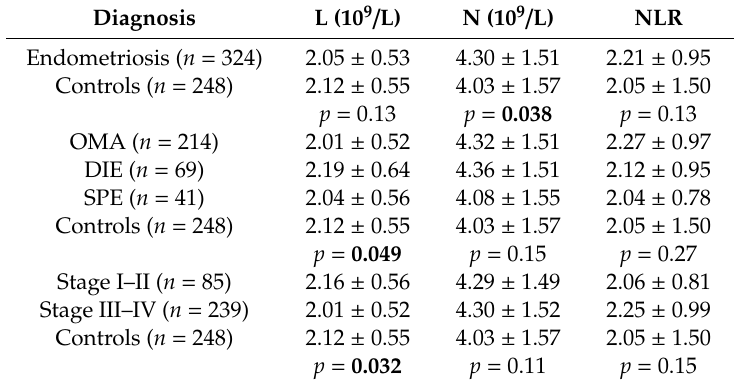
Table 2. Systemic inflammatory response parameters according to the di ff erent stage and type of endometriosis versus